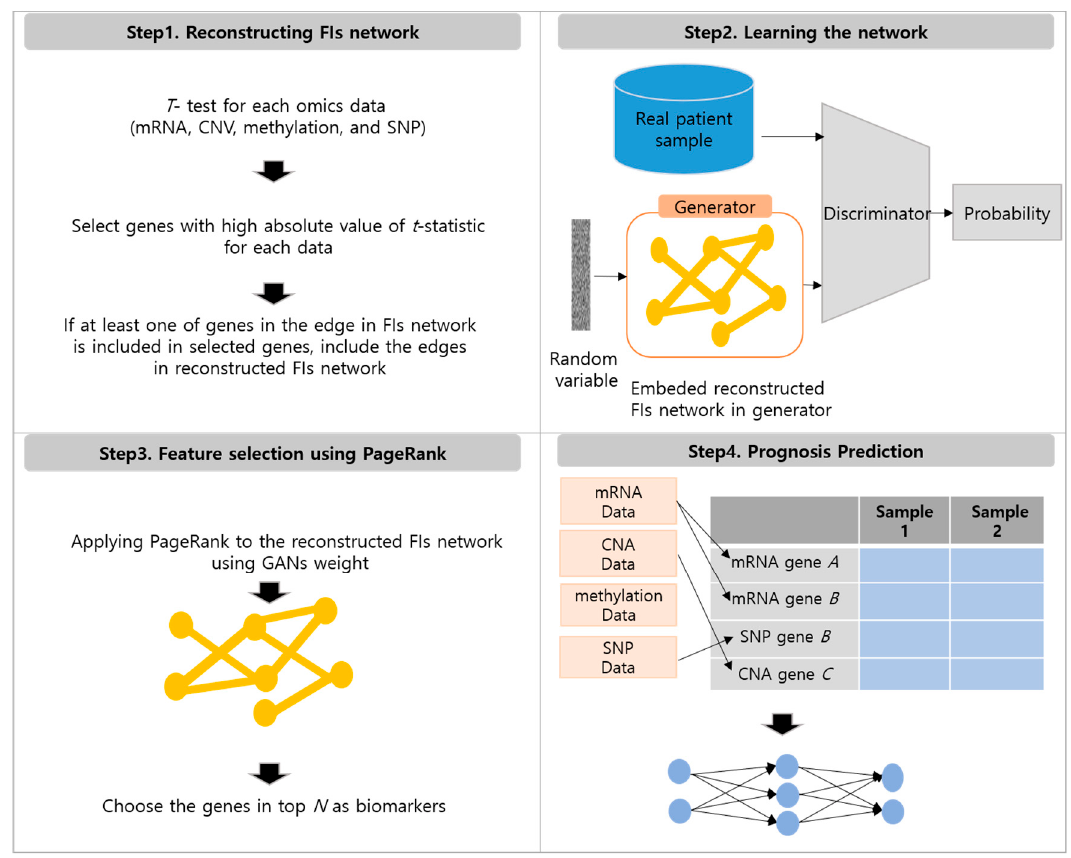
Figure 1. Overview of the method. First, FIs network is reconstructed. Second, reconstructed FIs network is trained using generative adversarial networks (GANs). Third, PageRank algorithm is applied to the reconstructed FIs network using GANs weights, and top N biomarkers are selected. Finally, features are selected and patient's prognosis is predicted using Multi-Layer Perceptron [19].